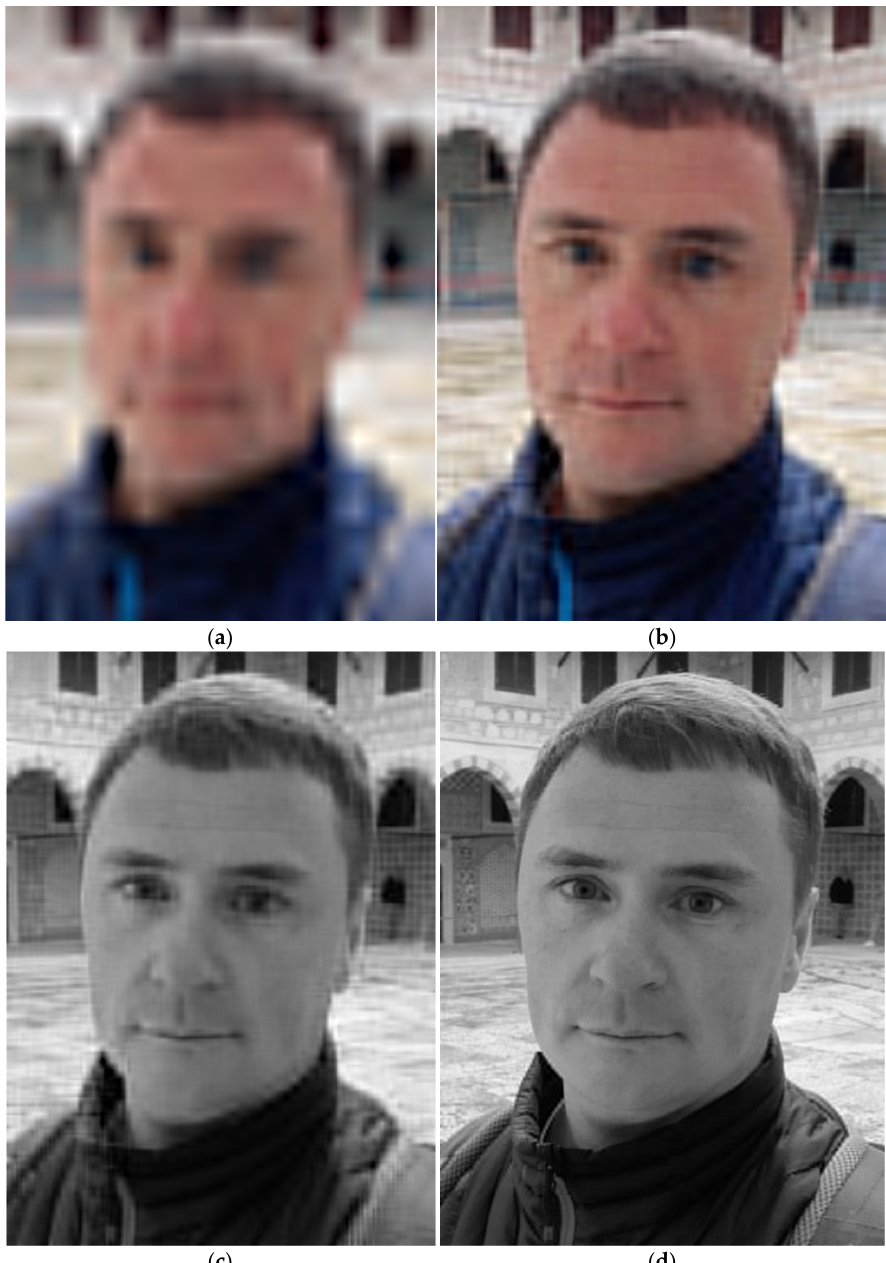
Figure 12. Representation of the image shown in Figure 11a by different number of DAT-coeffi- cients: 0.34 percent of all values ( a ); 1.32 percent of all values ( b ); 1.73 percent of all components ( c ); 11.2 percent of all components ( d